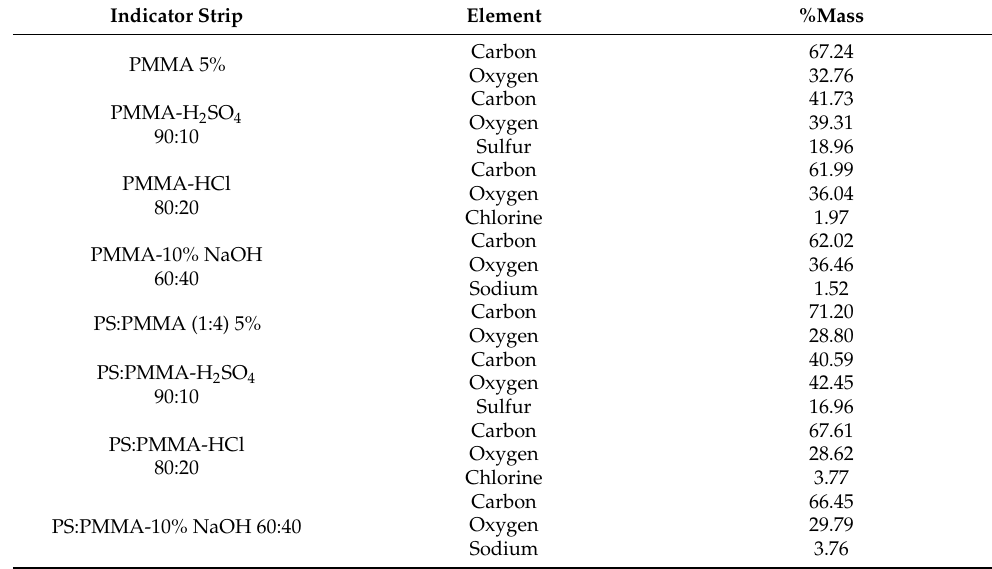
Table 4. Elemental mass percentage in the indicator